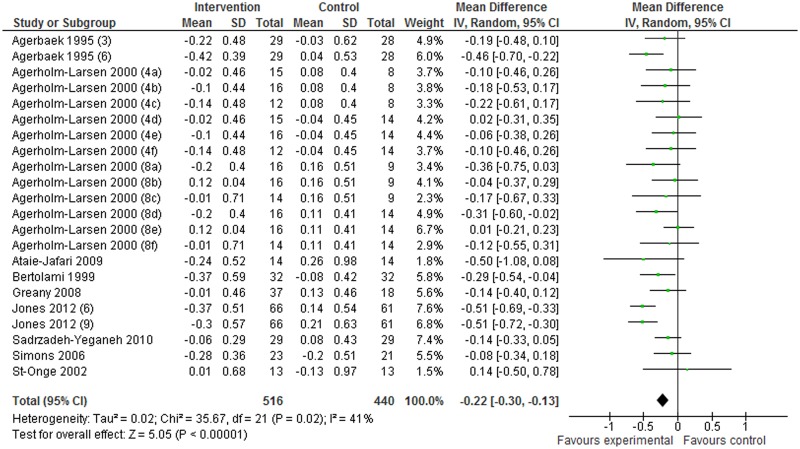
Effects of probiotics on changes in serum LDL-C levels.Values in parentheses indicate intake duration (weeks). a, b, and c in parentheses indicate Gaio, Stra, and StLa vs PP, respectively; d, e, and f in parentheses indicate Gaio, Stra, and StLa vs PY, respectively. PP: placebo pill; PY: placebo yogurt; StLa: Streptococcus thermophilus and Lactobacillus acidophilus; StLr: Streptococcus thermophilus and Lactobacillus rhamnosus.